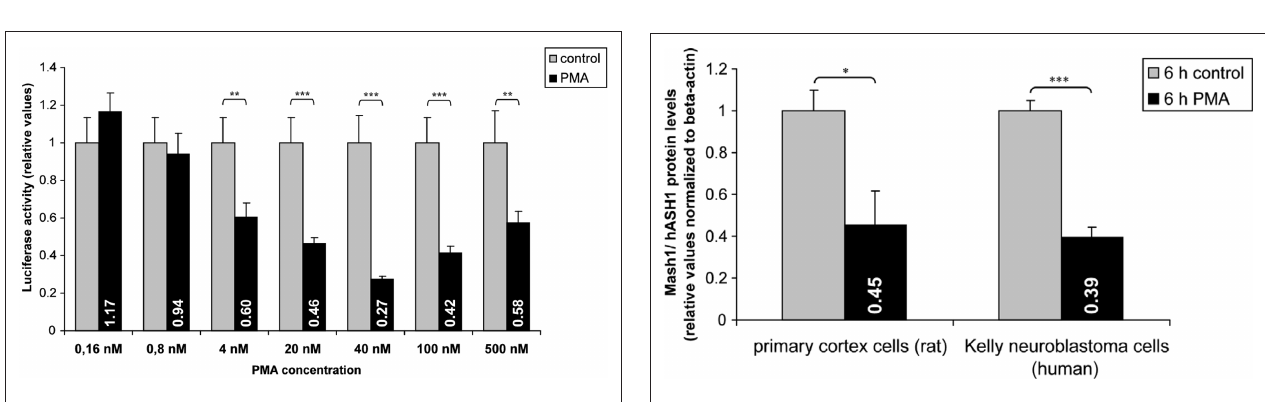
Figure A3 | Phorbol 12-myristate 13-acetate mediated suppression of Mash1/hASH1 protein levels. Isolated primary cortex cells of the rat and human neuroblastoma-derived Kelly cells were treated for 6 h with PMA (40 nM). Relative Mash1/hASH1 protein levels were quantified by